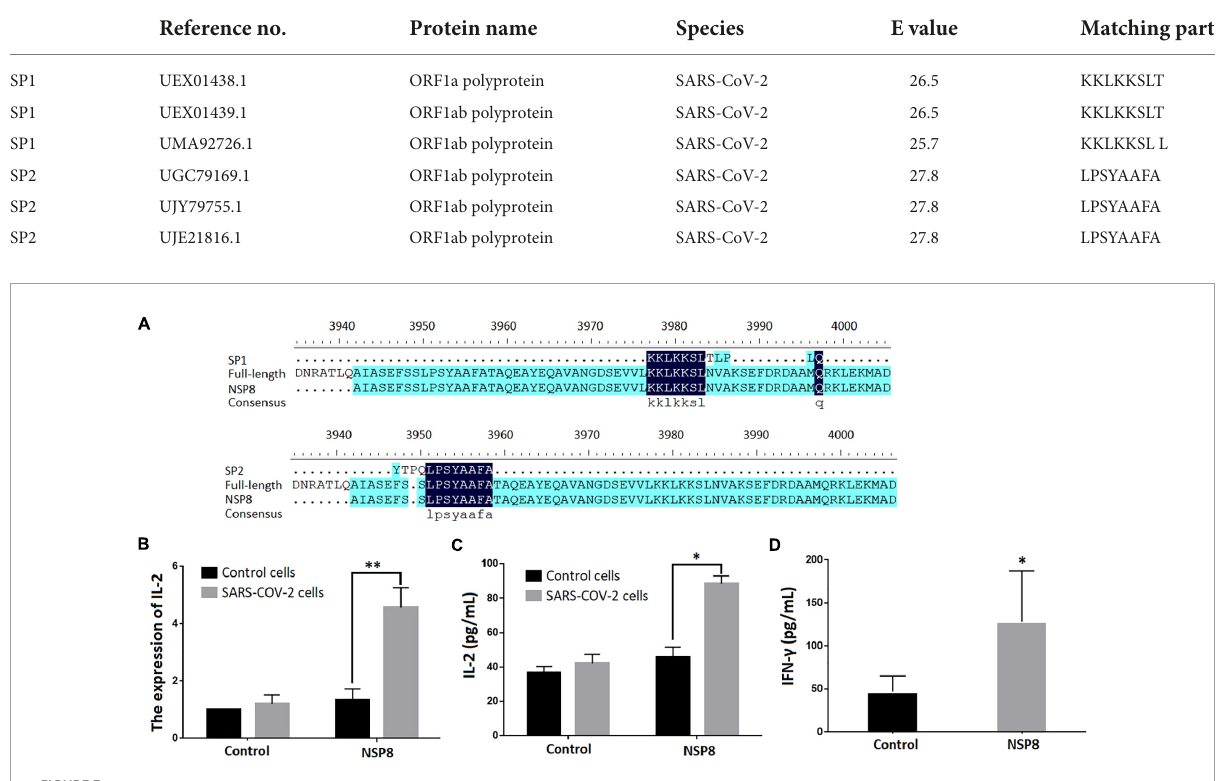
FIGURE3 NSP8 protein contains potential epitopes that could activate γδ T cell. (A) The sequence alignment of two peptide candidates with the sequence of SARS-CoV-2 and NSP8 protein sequence. (B,C) NSP8 protein could stimulate SARS-CoV-2 specific γδ TCR transfected cells to produce more IL-2. The control protein and NSP8 protein were pre-coated in a 24-well plate. The SARS-CoV-2-specific γδ TCR transfected cells were then added and cultured for 24 h. IL-2 secretion was measured either by RT-PCR (B) or by ELISA (C) . (D) NSP8 protein could bind to natural peripheral γδ T cells. The control protein and NSP8 protein were pre-coated in a 24-well plate and incubated with γδ T cells isolated from five healthy donors’ peripheral blood. IFN- γ secretion was measured in supernatants collected 24 h after incubation. Data were presented as mean ± SD from triplicate experiments. ∗ Denotes p < 0.05; ∗∗ Denotes p <